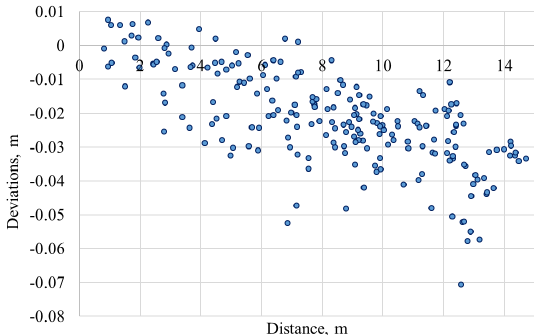
Figure 5. Distances deviations Matterport vs. FARO Scanner